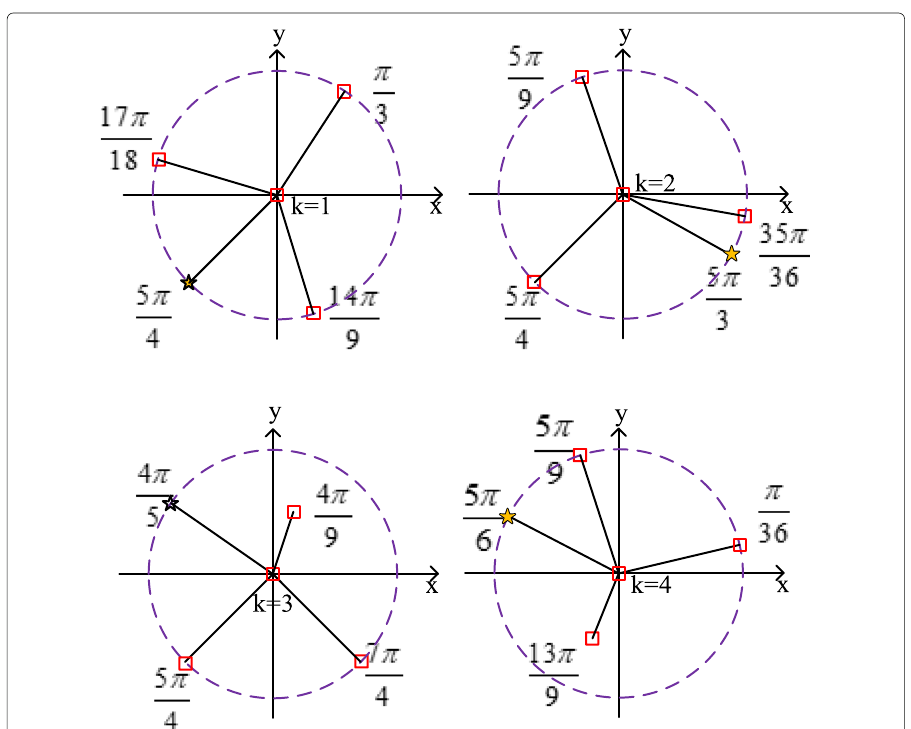
Fig. 5 Topology of agent k ∈ N k in single anchor-based cooperative localization: its 4 neighbors include the single anchor and 3 other hearable agents